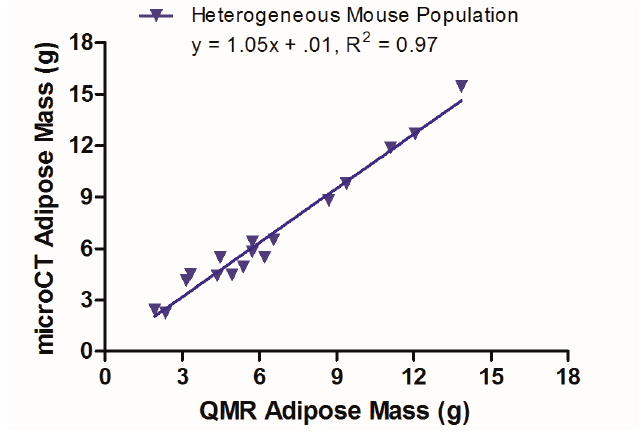
Figure 4. Linear regression of microCT and QMR adipose values for a mouse population with heterogenous genetic